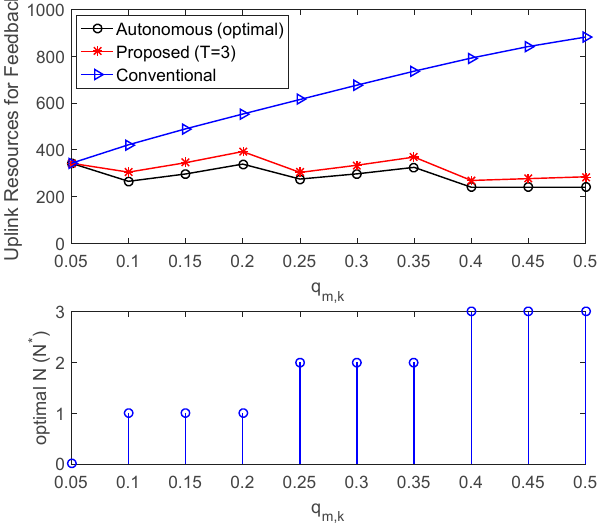
Figure 10. Comparison of required uplink resources for ACK/NACK feedback and optimal N according to different value of q m,k when K = 10.